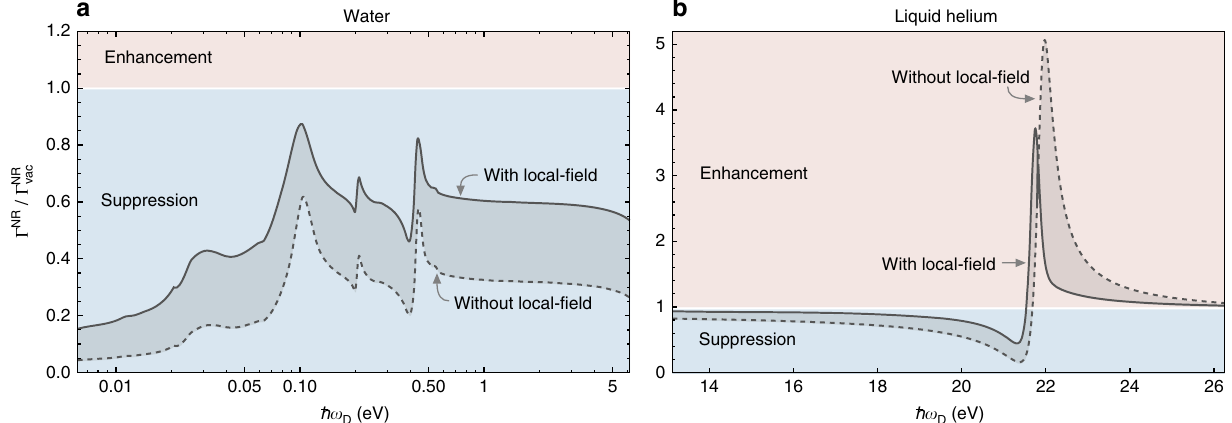
Fig. 3 Effect of solvent media on interatomic Coulombic decay rate. Non-retarded interatomic Coulombic decay rate Γ NR in a liquid water and b liquid helium, using tabulated optical data 40,41 . The results are normalised to the non-retarded rate Γ NR the main text, the bulk medium can enhance or suppress the ICD rate, and the local- fi eld effect can cause an additional suppression or enhancement relative to the results without the local- fi eld effect